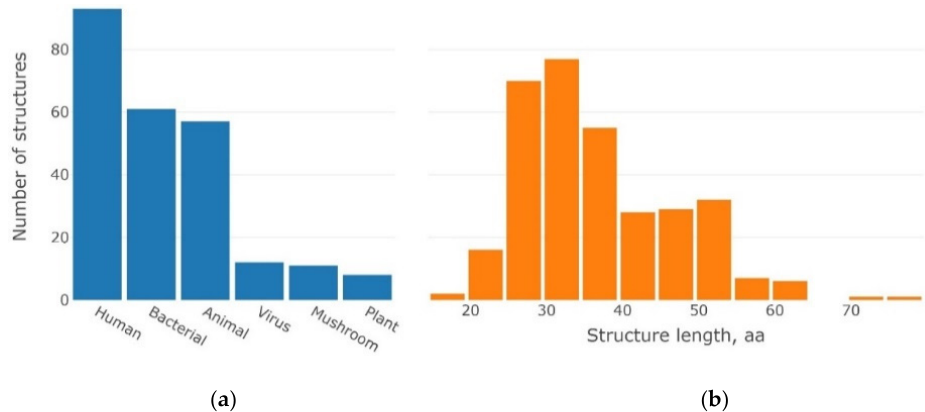
Figure 7. Origin of proteins in which 3 β -corners were identified ( a ); length distribution of 3 β -corners in the examined dataset ( b ).